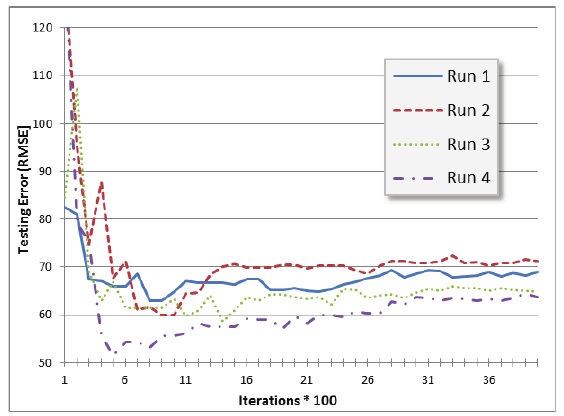
Fig. 11. The testing RMSE convergence during the evolution of the prediction model shown in Fig.4.